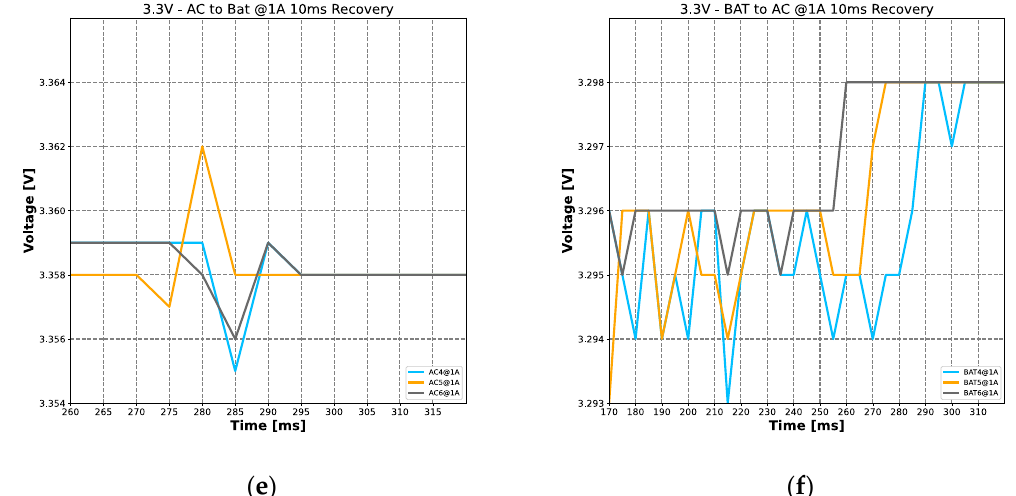
Figure 13. Graph of ( a ) Switching between AC and battery on 12 V with 1 A, ( b ) Switching between battery and AC on 12 V with 1 A, ( c ) Switching between AC and battery on 5 V with 1 A, ( d ) Switch- ing between battery and AC on 5 V with 1 A, ( e ) Switching between AC and battery on 3.3 V with 1 A, ( f ) Switching between battery and AC on 3.3 V with 1 A.